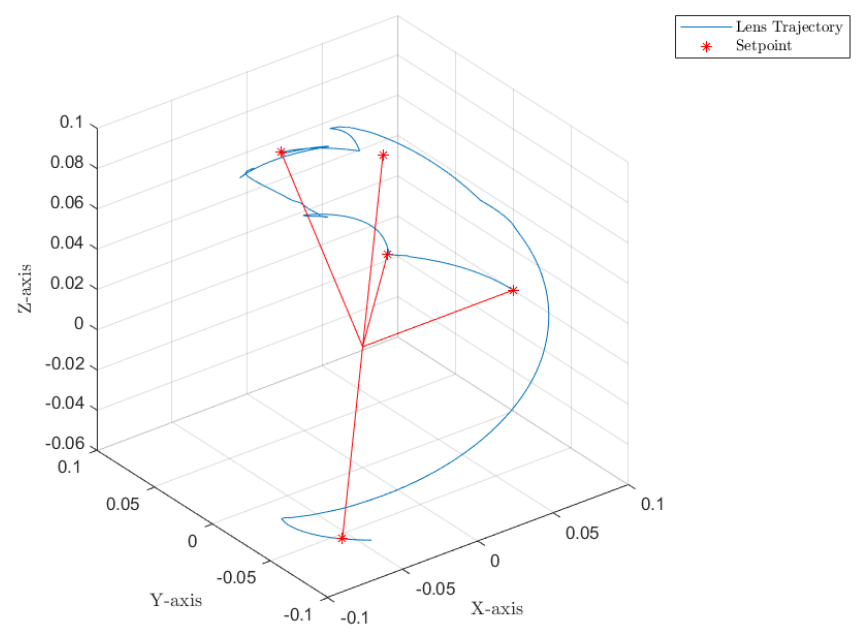
Figure 17. Combined trajectories of Links 1 and 2 to form the camera path in R 3 Cartesian